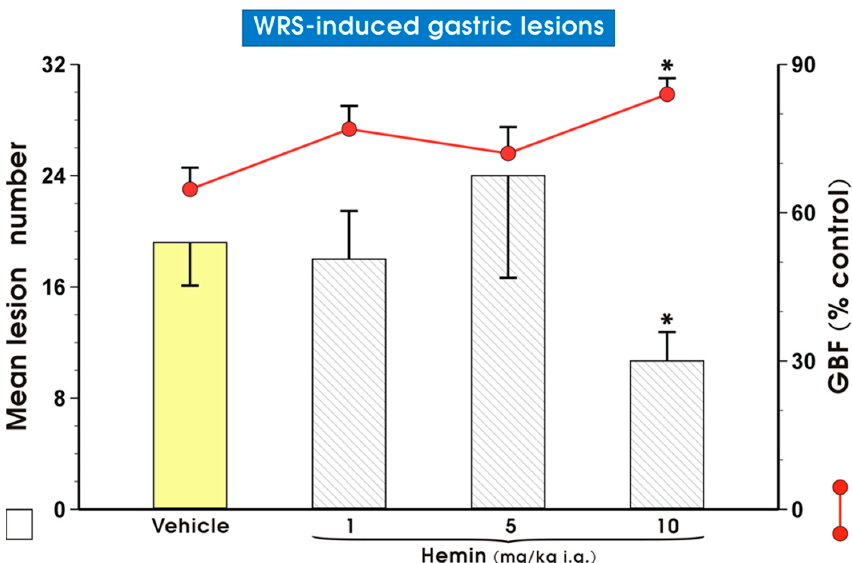
Figure 3. Mean lesion number and gastric blood flow (GBF) in gastric mucosa pretreated i.g. with vehicle (saline) or hemin administered in increasing doses ranging from 1 up to 10 mg/kg i.g. and exposed 30 min later to water immersion and restraint stress (WRS). Results are mean ± S.D. of 4–6 animals for each experimental group. Asterisk indicates significant change ( p < 0.05) as compared with vehicle (saline).